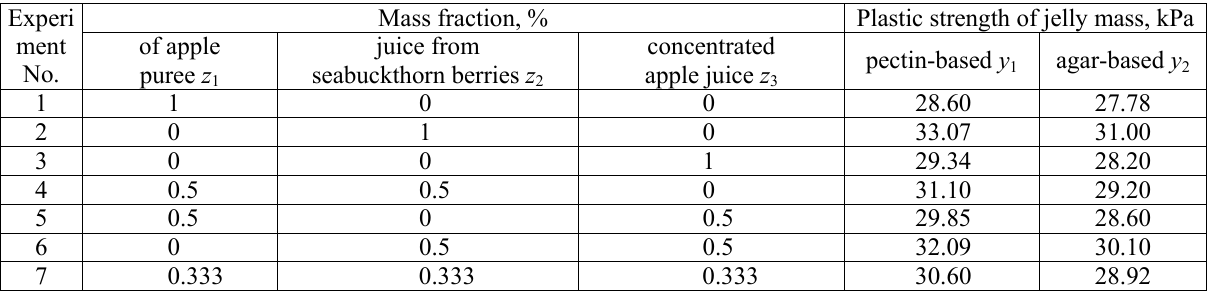
Table 2 . Simplex-centroid planning conditions